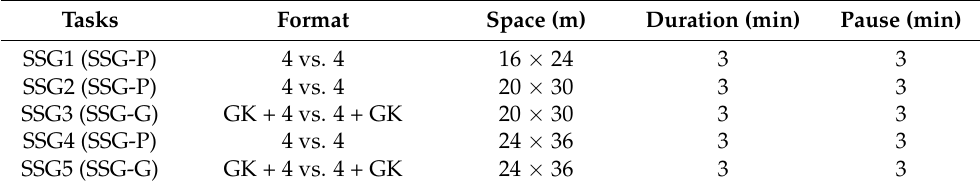
fat: 10.1 ± 2.2 % and experience: 13.3 ± 1.5 years) and two GK (age: 20.5 ± 2.1 years old; height: 1.91 ± 0.04 m; total body mass: 77.0 ± 1.4 kg; body fat: 9.7 ± 1.2 % and